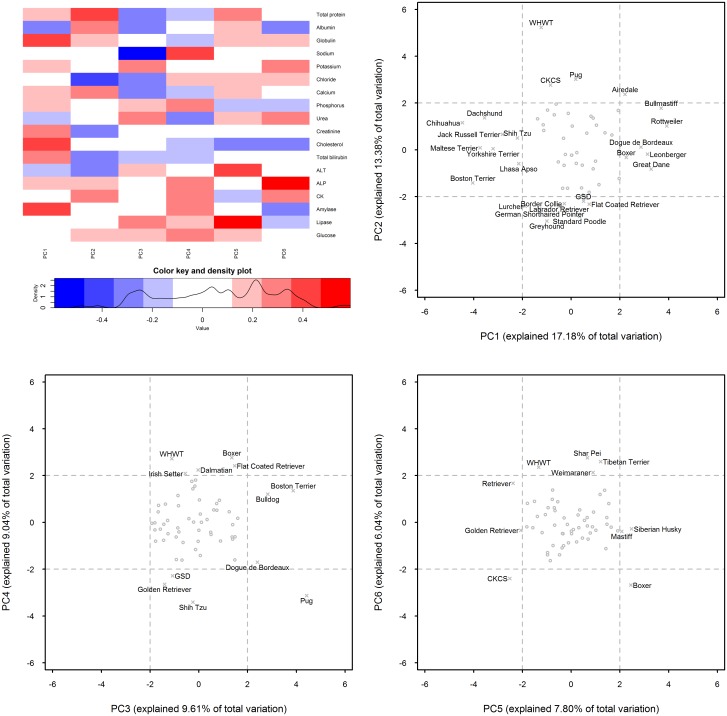
Principal component analysis identifies breed-specific serum biochemical phenotypes.Of the 18 principal components identified in the current dataset, the first six had Eigenvalues of over 1 and cumulatively accounted for 63% of the total variance. A heat map showing correlations between the serum biochemical parameters and the first six principal components (PC1 to PC6) is shown in part (a). Biplots (PC1 vs PC2; PC3 vs PC4; PC5 vs PC6) are shown in part (b), revealing outlying breeds with principal components of greater than +2 and less than -2, representing distinctive phenotypes. These outlying breeds are labeled in the biplots.